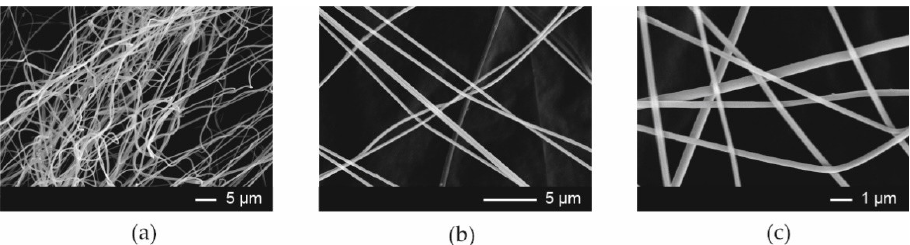
Figure 2. Scanning electron microscopic images of electrospun films (Esp ODF, magnification ( a ) 2000×; ( b ) 5000×; ( c ) 10,000×).